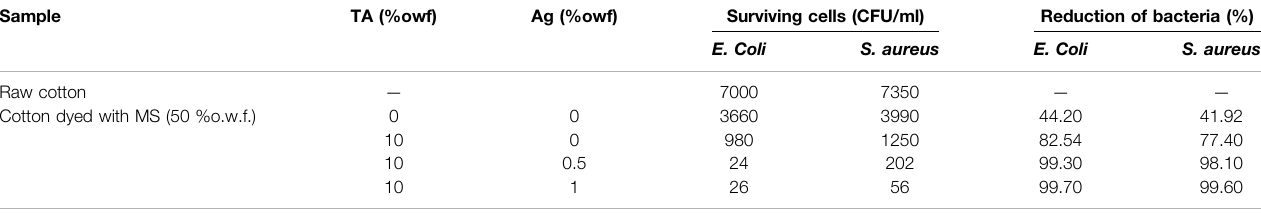
TABLE 6 | Antibacterial activity of cotton samples at various conditions; the concentration of TA and Ag were % owf. Sample TA (%owf)